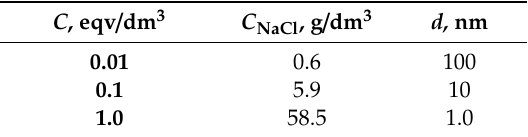
Table 4. Approximate diameters of mesopores at which the process of capacitive desalination of solutions of di ff erent concentrations can be carried out.